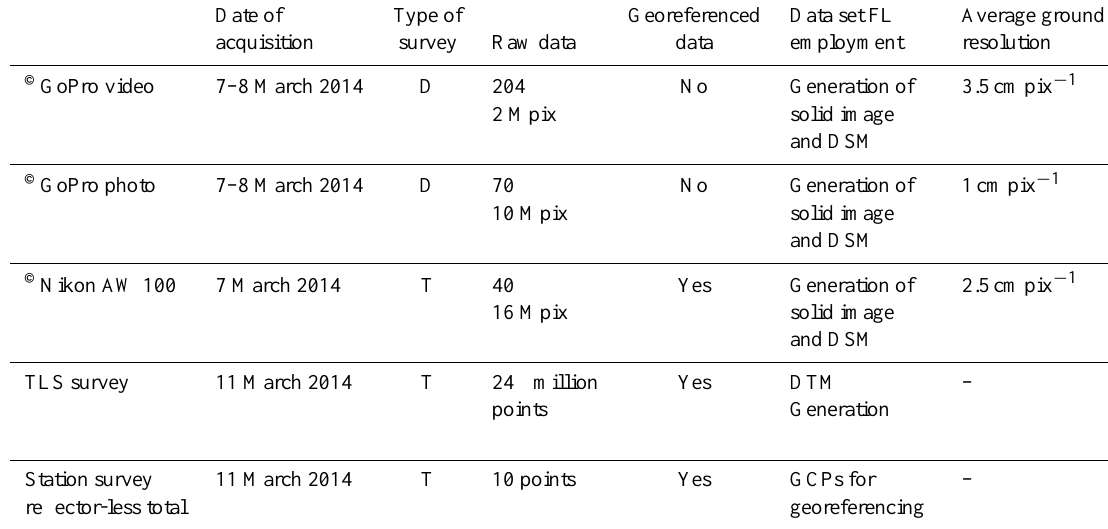
Table 1. Summary of the data and results obtained for the San Germano case study. Date